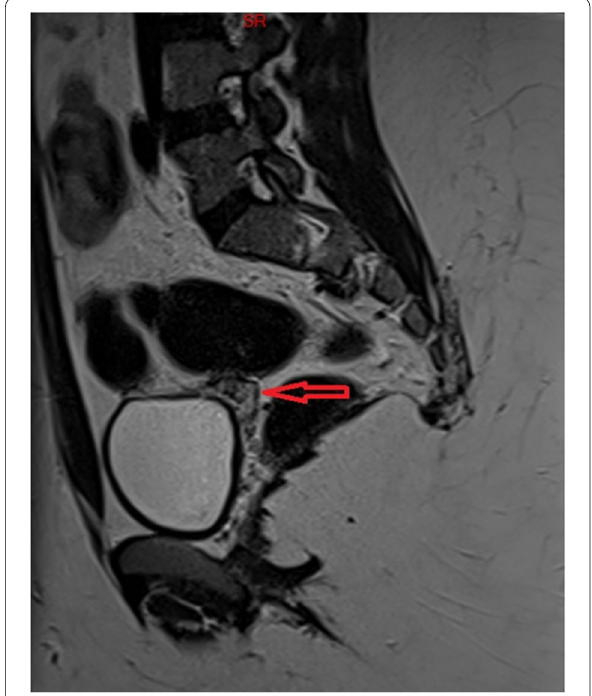
Fig. 1 Sagittal T2WIs pelvic MRI showed midline uterine bud (red arrow) behind the dome of the urinary bladder with cystic